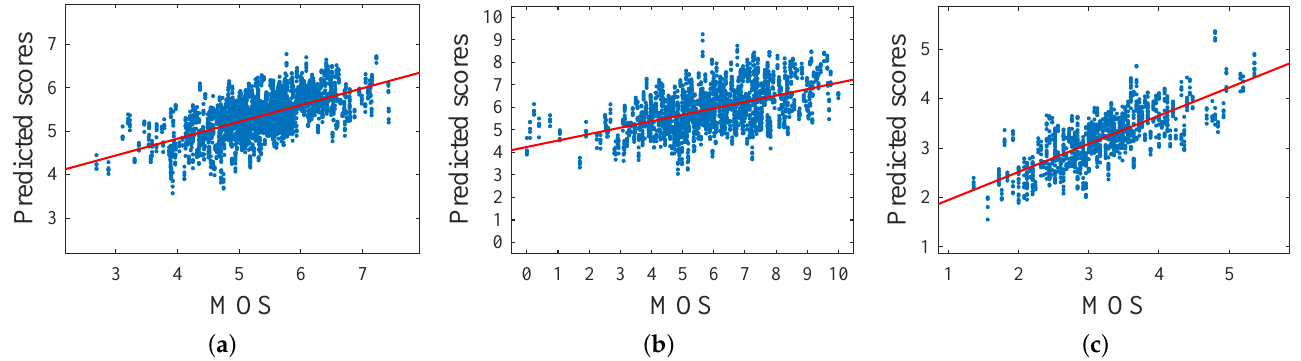
Figure 15. Scatter plots of predicted scores versus the MOS for the databases: ( a ) FAVA, ( b ) Flickr, ( c ), and HFS using perceptual features extracted from the face